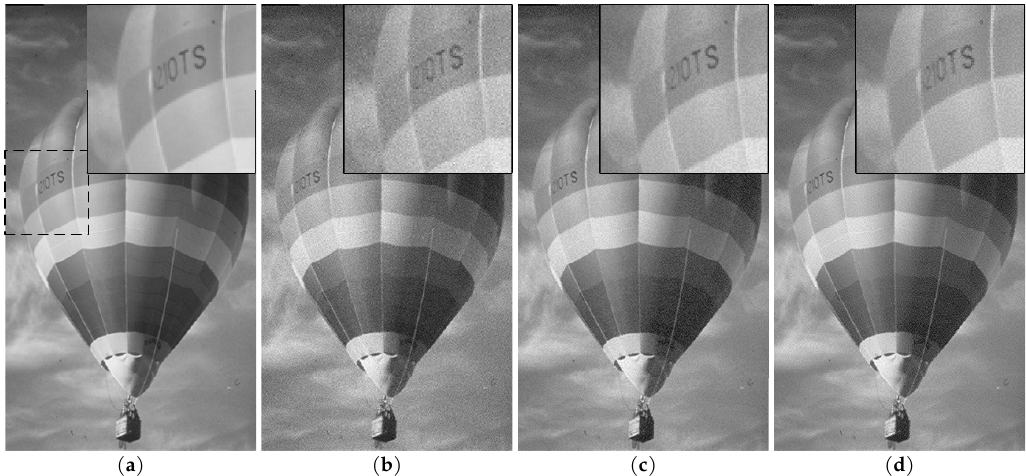
Figure 24. Visualization of JND-contaminated images: ( a ) original section of the BALLOON image; ( b ) contaminated with white noise, PSNR = 31.98; ( c ) contaminated with JND profile given by Chou and Li’s model [9] with random-sign injection, PSNR = 31.97; and ( d ) contaminated with JND profile given by the proposed JND model with zero-mean random-sign injection, PSNR = 31.74.